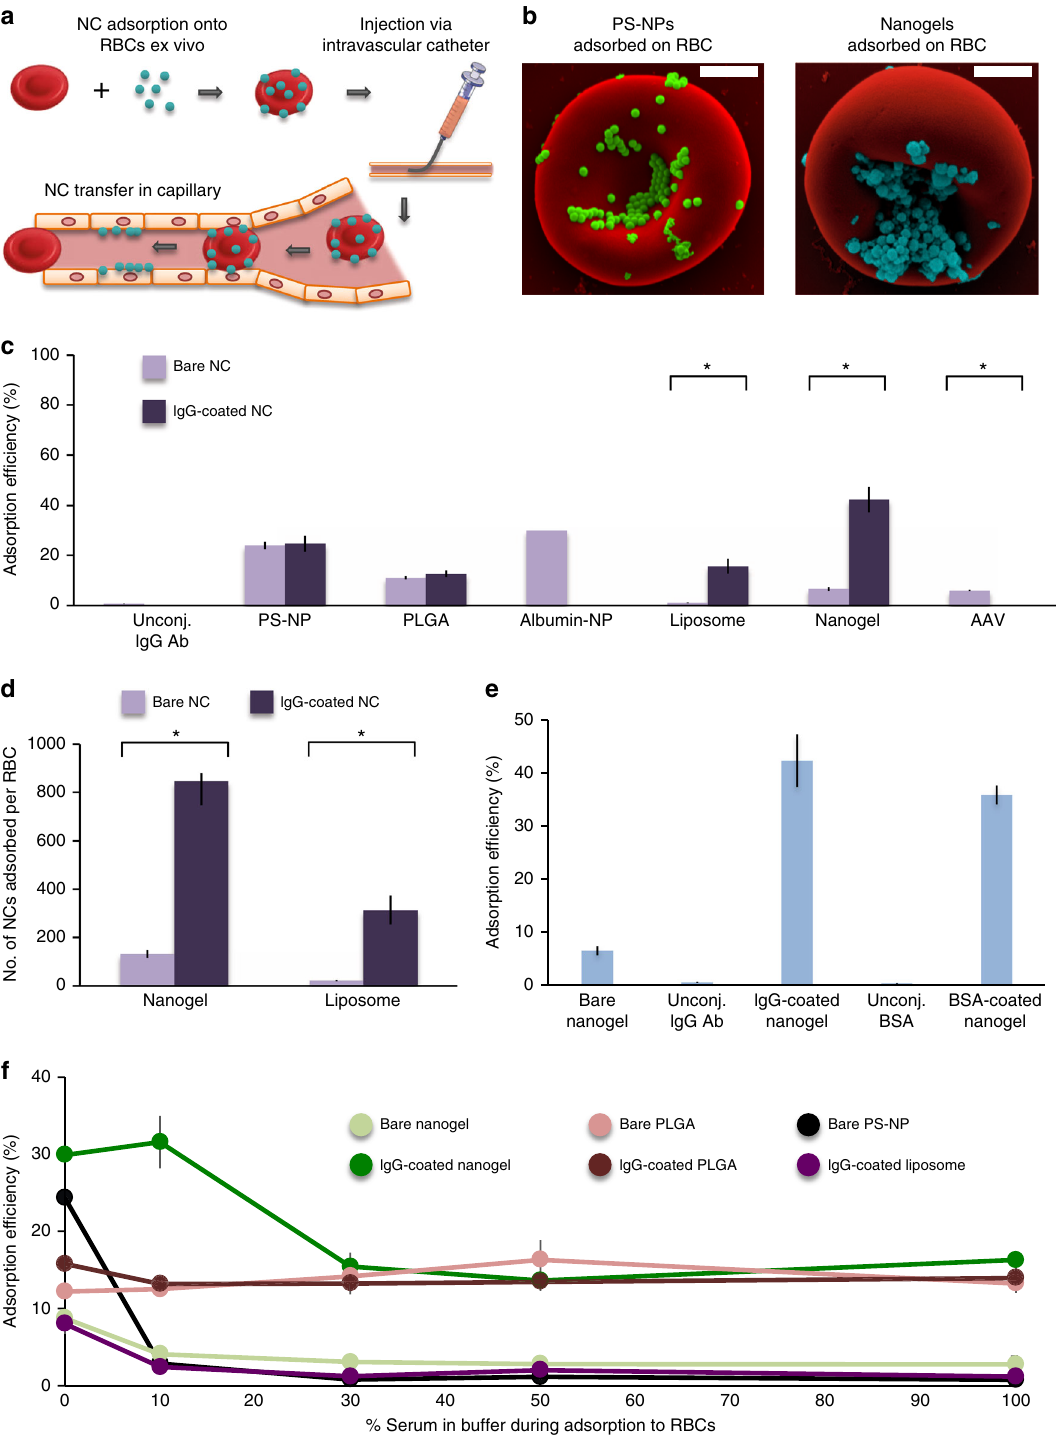
Fig. 1 Clinically translatable nanocarriers adsorb onto red blood cells. a Procedural steps of RBC hitchhiking. NCs are fi rst adsorbed onto the RBCs ex vivo. The RBC – NC complexes are then injected via an intravascular catheter, after which the NCs transfer from the RBCs to the fi rst downstream organ ’ s capillaries. b Scanning electron micrographs of PS-NPs and nanogels attached to the surface of murine RBCs. NCs were mixed with RBCs in vitro, leading to adsorption of NCs onto the RBCs. Scale bars = 1 μ m. c Ef fi ciency of radiolabeled NC adsorption onto RBCs, as de fi ned by the % of total NC added to RBCs that pellet with RBCs. d Number of NCs adsorbed per RBC when NCs were mixed with RBCs at a ratio of 2000 NCs per RBC. e Adsorption ef fi ciencies onto RBCs of free proteins (IgG and BSA) compared to free nanogels and to nanogels coated with each protein. f Adsorption ef fi ciencies of unmodi fi ed and IgG-coated NCs with increasing concentrations of serum present in the buffer during adsorption. Each data point represents mean ± s.e.m ( n = 3). * P < 0.05, non-paired, two-tailed t